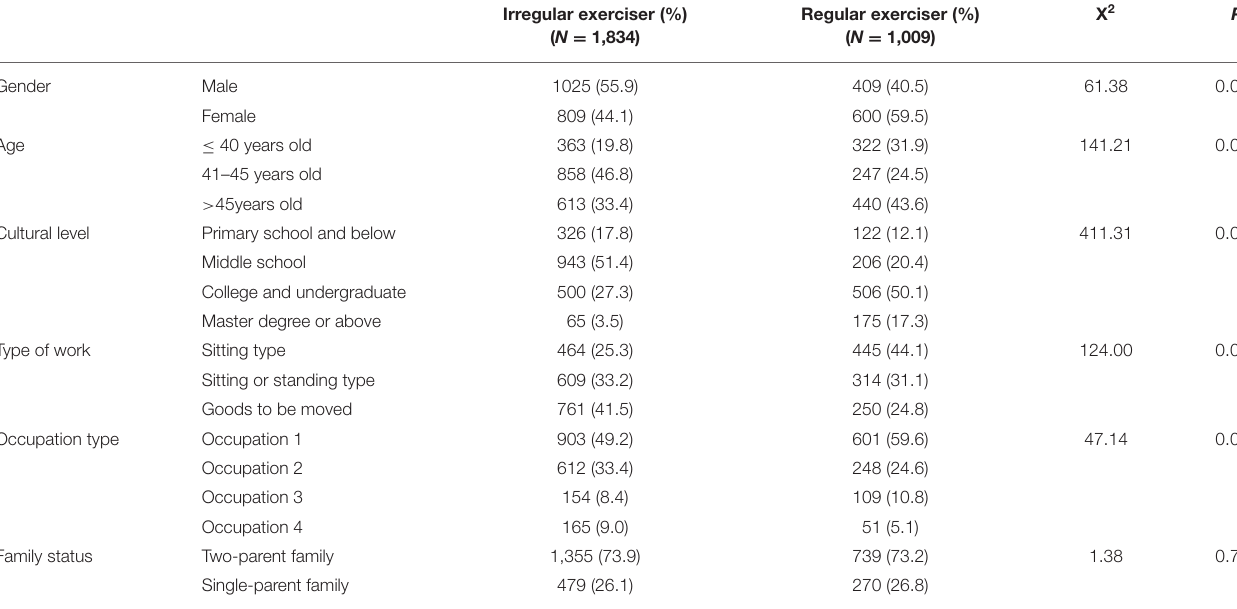
TABLE 2 | Analysis of social and demographic data of regular and irregular athletes (overall effective n = 2,843).